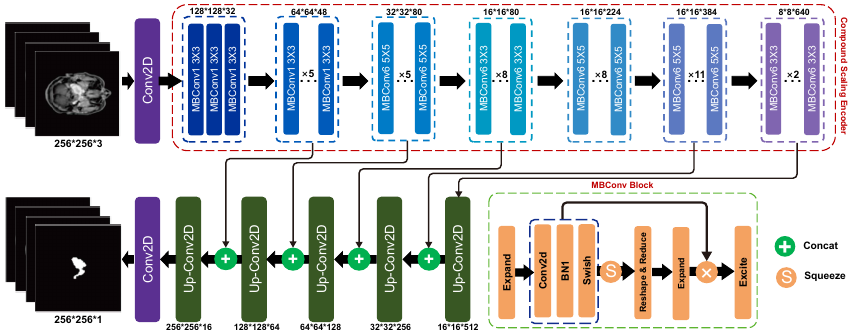
Figure 2. Network of LW-UNET: The Compound Scaling Encoder of LW-UNet consists of seven MB- Conv blocks of different sizes. Decoder is composed of a series of up-convolutions, and through skip connection and up-convolution can obtain the final segmentation map of nasopharyngeal